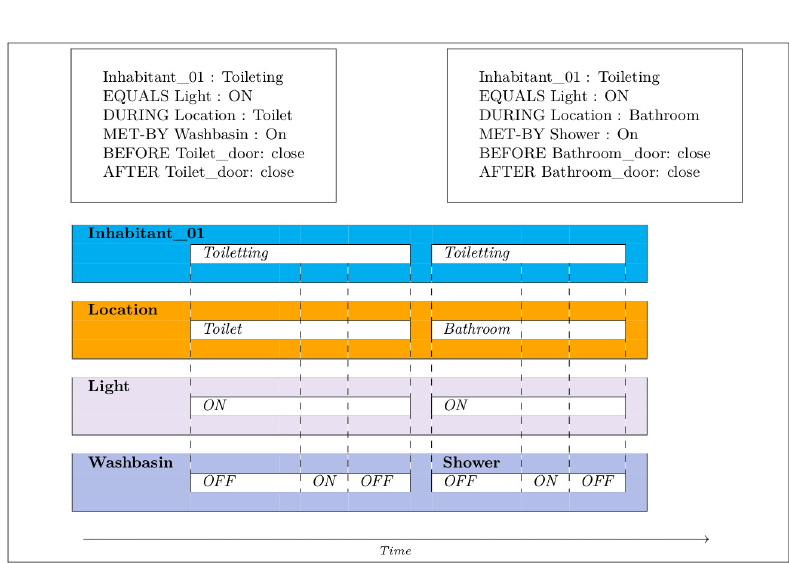
Figure 4. Transfers.